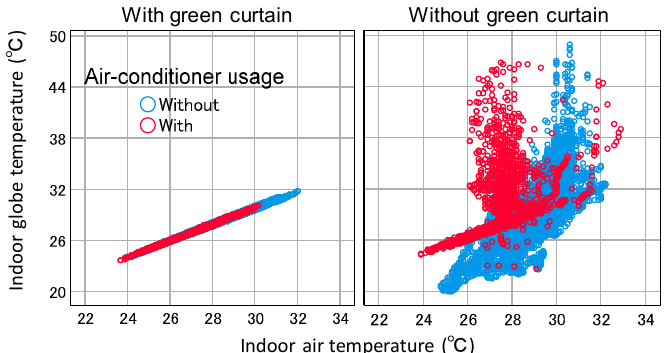
Figure 18. Relationship between the indoor globe temperature and indoor air temperature with green curtain and without the green curtain.